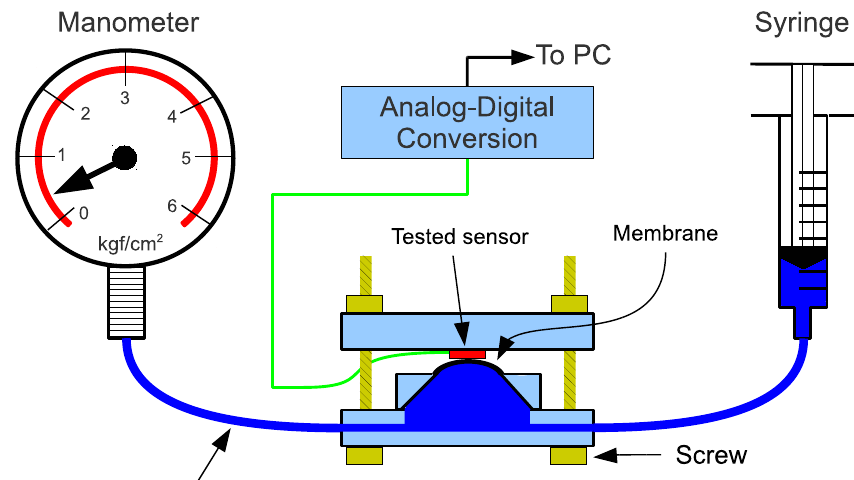
Figure 4. Calibration system for pressure sensors. Based on the leaf Wiltmeter developed by Calbo and Pessoa